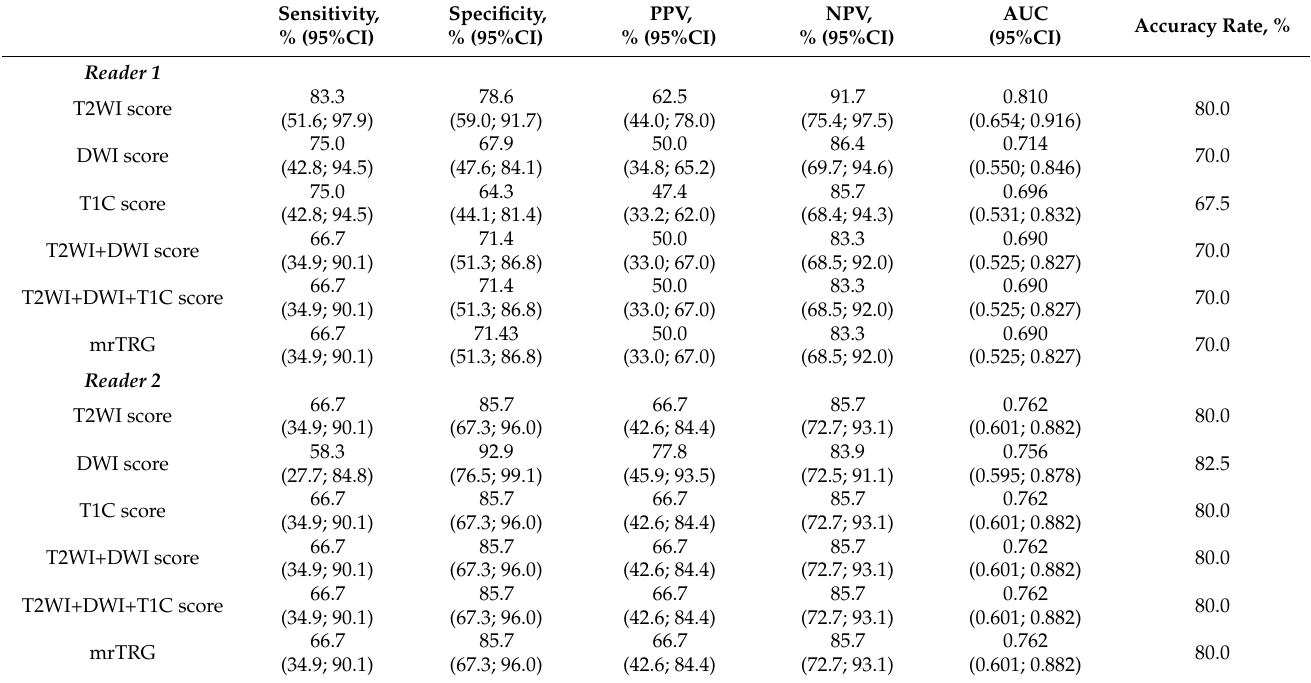
Table 6. Diagnostic performance of restaging MRI according to Reader to correctly identify near- complete